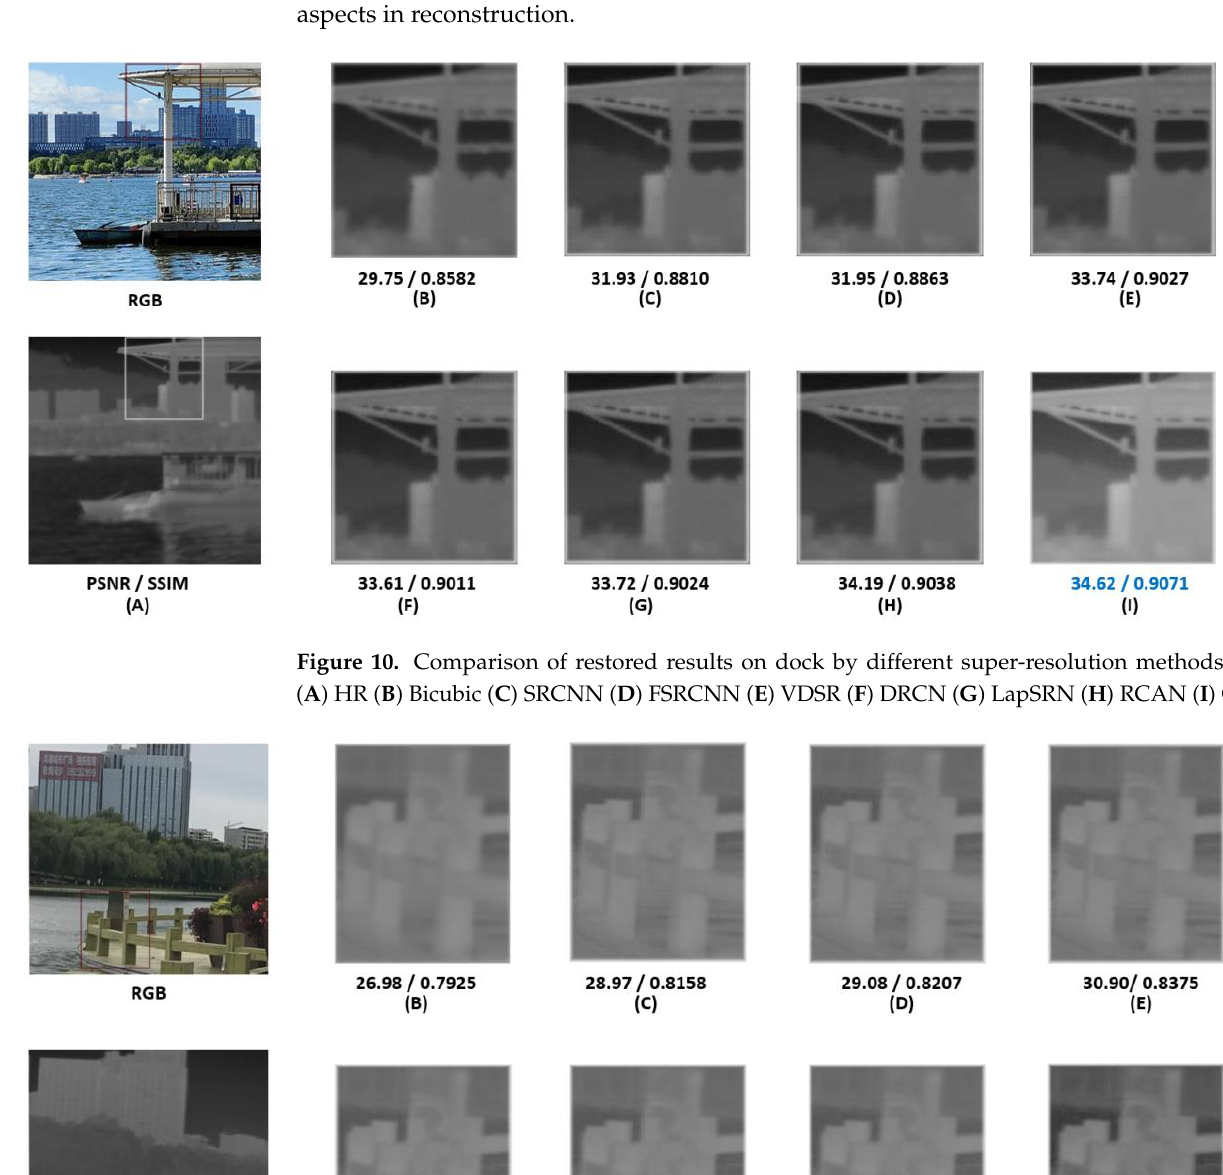
Figure 11. Comparison of restored results on platform by different super-resolution methods (4×).